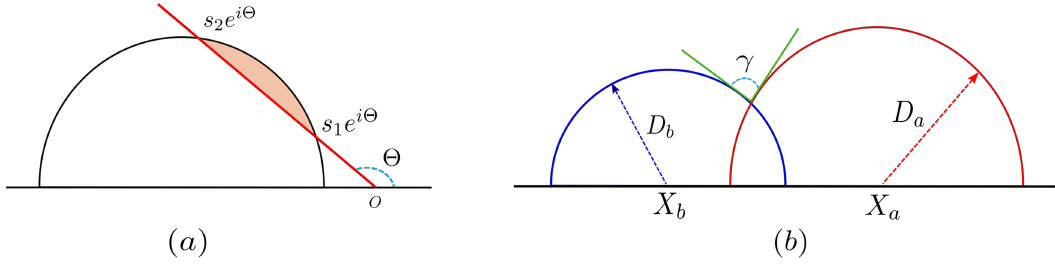
Figure 8. (a) Area enclosed by the brane and a part of infalling geodesic. (b) Angle between two intersecting